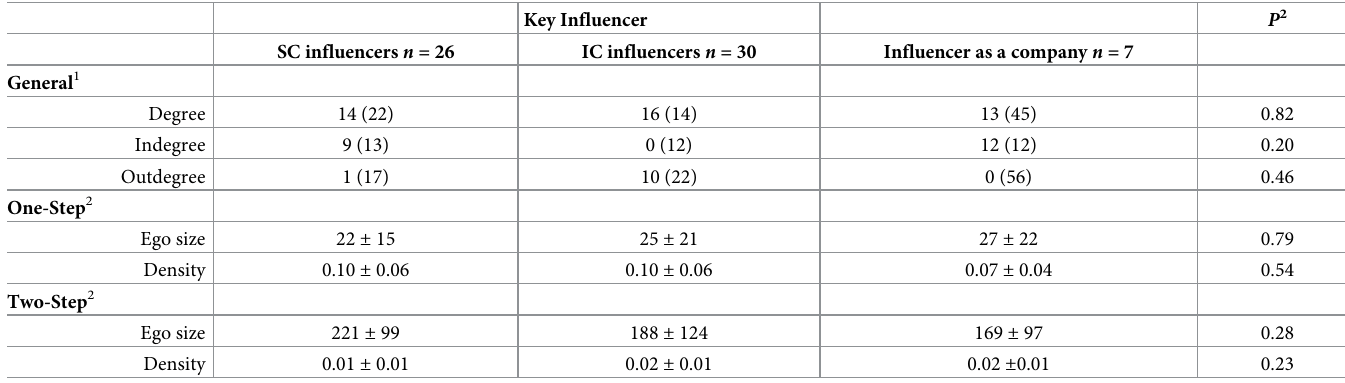
Table 1. Differences in structural metrics of key influencers’ ego networks by category. Key Influencer P